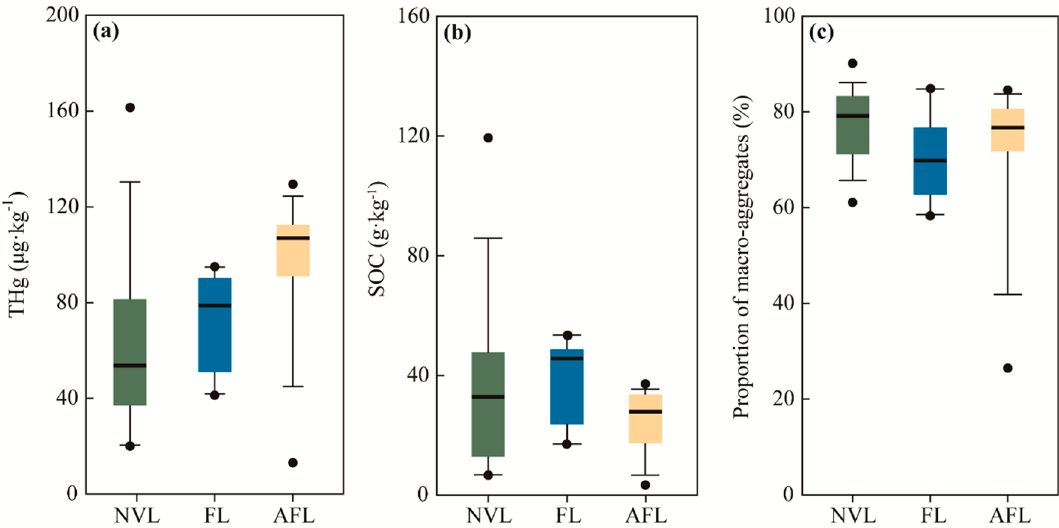
Figure 2. THg concentration ( a ), SOC concentration ( b ), and proportion of macro-aggregates ( c ) in soil profiles from NVL, FL, and AFL (o represents outliers). NVL: native vegetation land; FL; farmland; AFL: abandoned farmland.